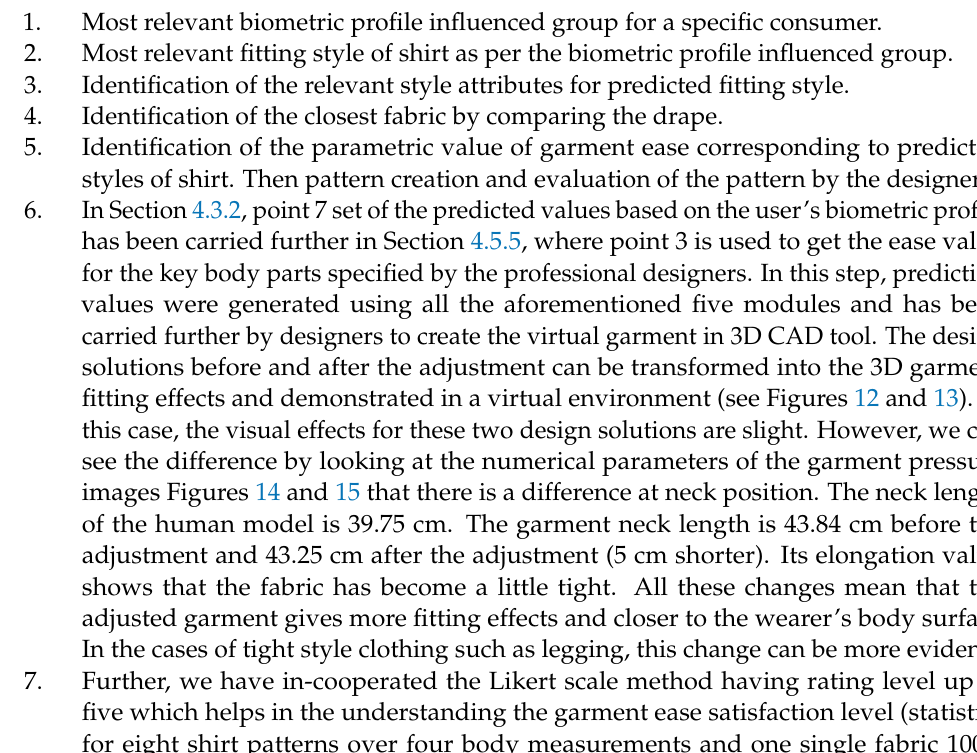
Figure 11. General architecture of the garment co-design interactive